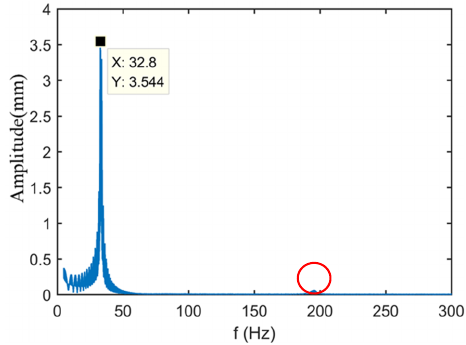
Figure 5. Single-side amplitude spectrum of cantilever structure. Appl. Sci. 2020 , 10 , x FOR PEER REVIEW